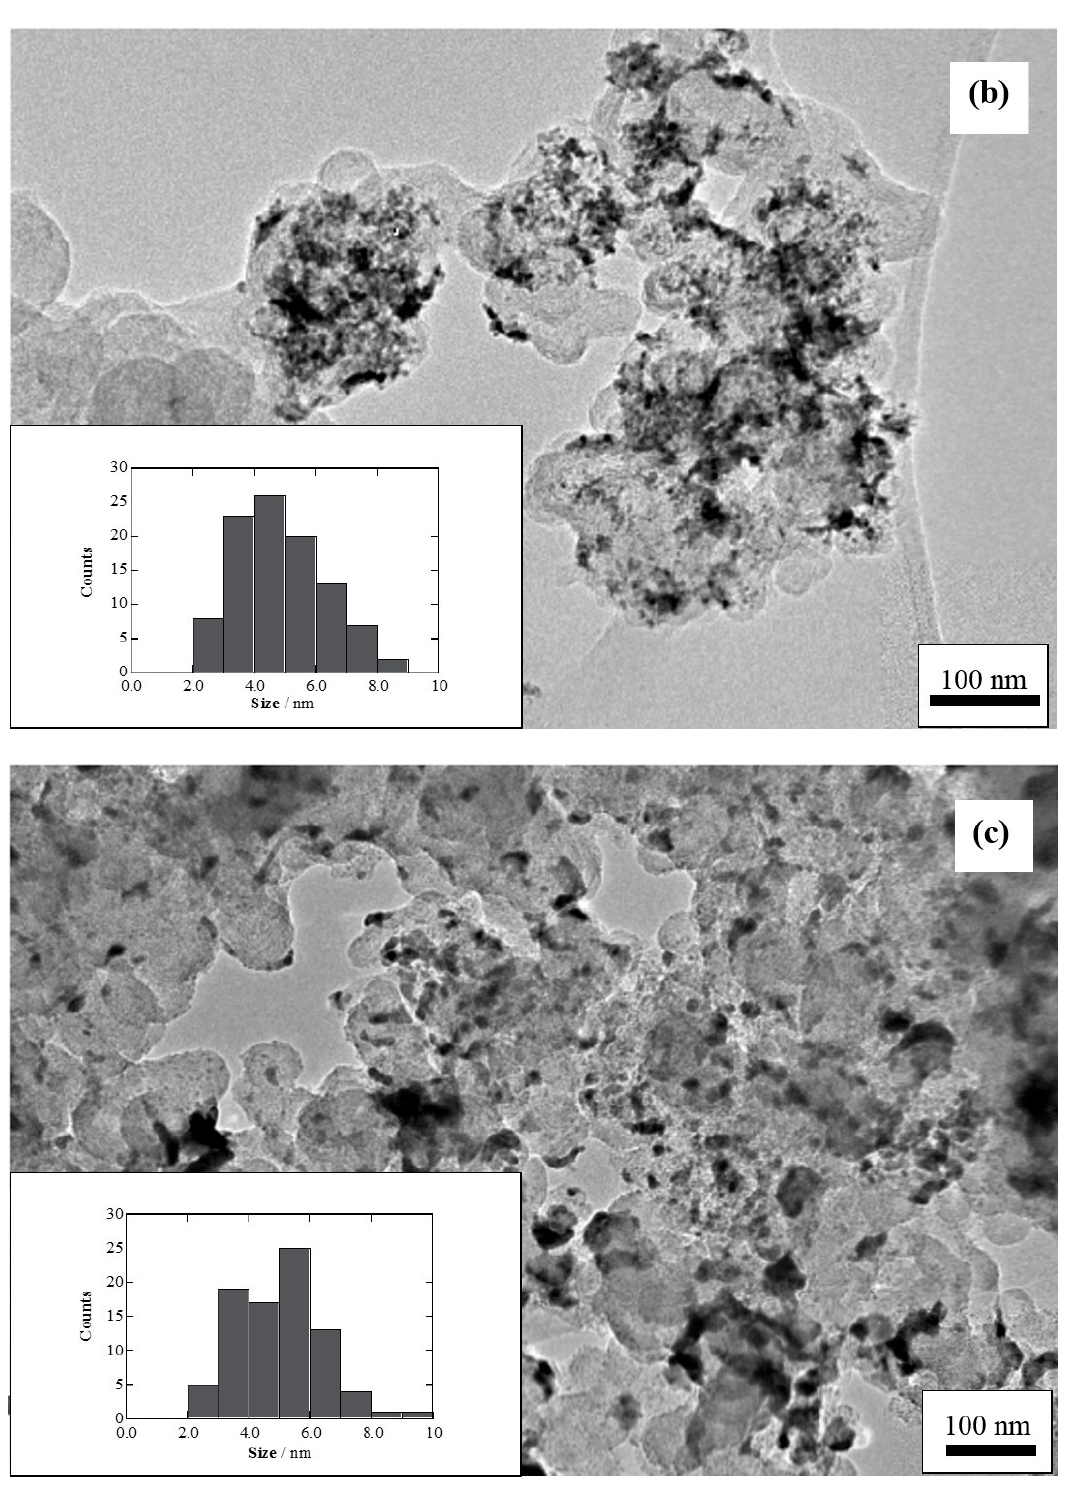
Figure 3. TEM analysis of the nanoparticles supported on Vulcan carbon XC72R prepared from a Cu electrodeposition charge of 45 mC and following the sequence i . ( a ) Cu/C; ( b ) Pt(Cu)/C; ( c ) Pt ‐ Ru(Cu)/C. The insets show the size distribution of the nanoparticles.